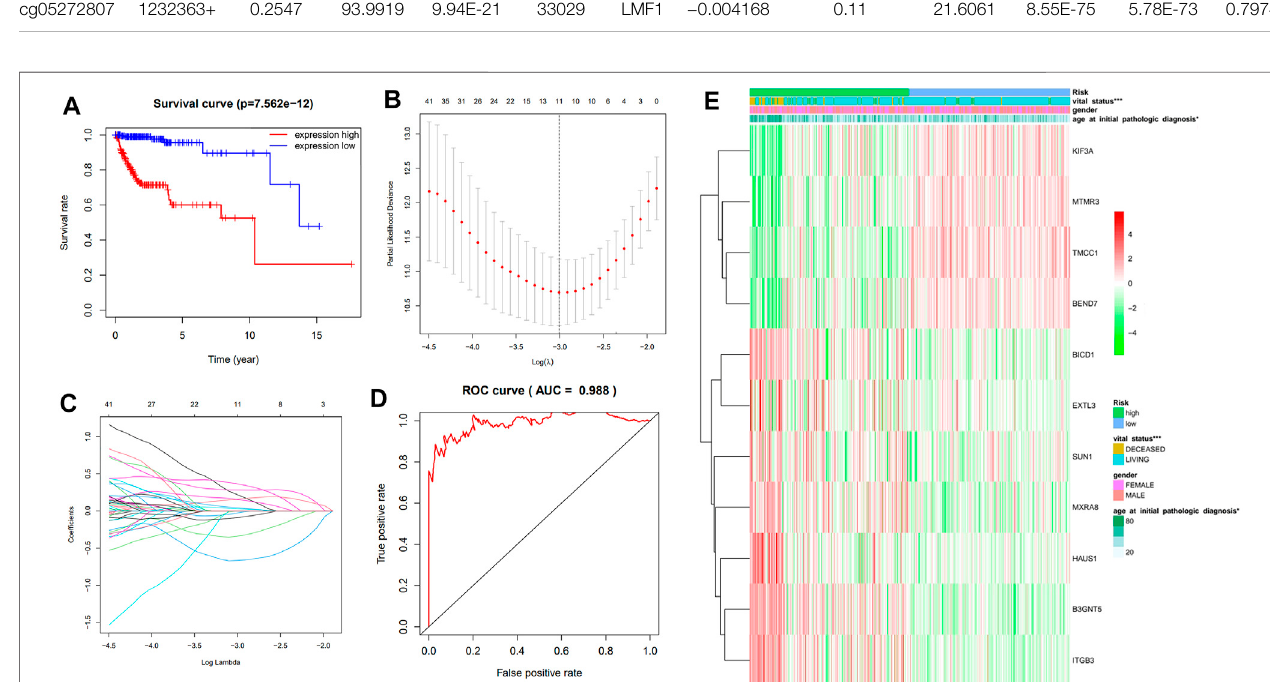
Frontiers in Genetics |